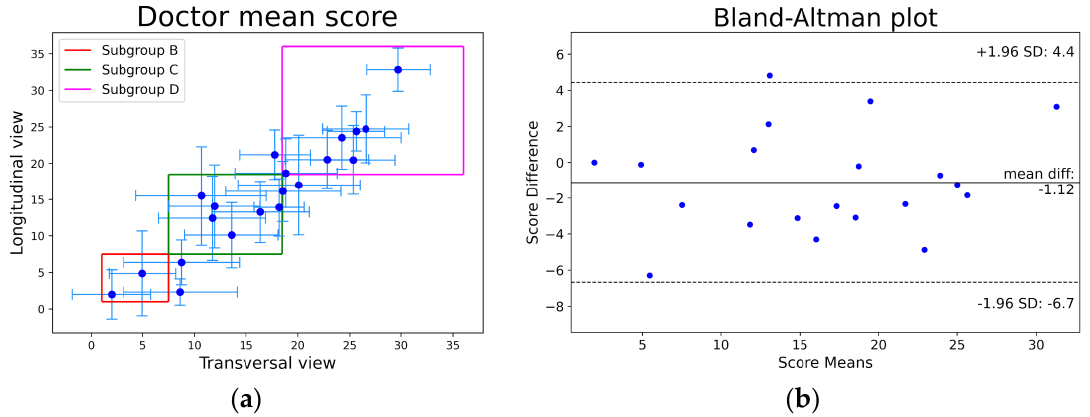
Figure 6. ( a ) Scatter plot with the longitudinal vs transversal total scores per patient. Points and error bars correspond to the average and standard deviation, respectively, of the evaluations obtained from all physicians. The 3 subgroups shown correspond to the classification of the patients based on their severity; ( b ) Bland – Altman plot of the total score per patient (obtained as the average value of all the evaluations) assigned to the videos acquired with longitudinal and transversal probe orientation ( “Score difference” indicates longitudinal minus transversal scores).